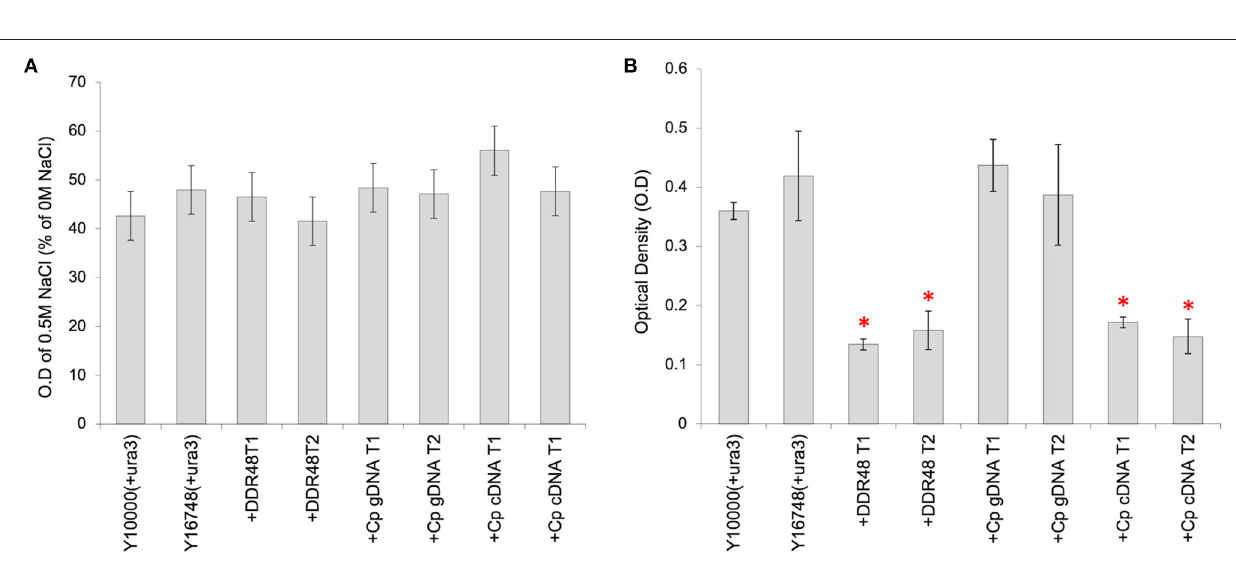
FIGURE 4 | (A) Agar spotting assays for salt tolerance of S. cerevisiae strain Y10000 and Y16748 showed no apparent difference. (B) The optical density (O.D) of Y10000 and Y16748 ( 1 ddr48 ) S. cerevisiae cultures 16h after inoculation in media containing a range of NaCl concentrations. Error bars represent the standard deviation of triplicates. * Denotes NaCl concentrations where the responses of Y10000 and Y16748 ( 1 ddr48 ) were found to be significantly different (as determined by a two-tailed t -test. See Supplementary Table 2 for P -values).